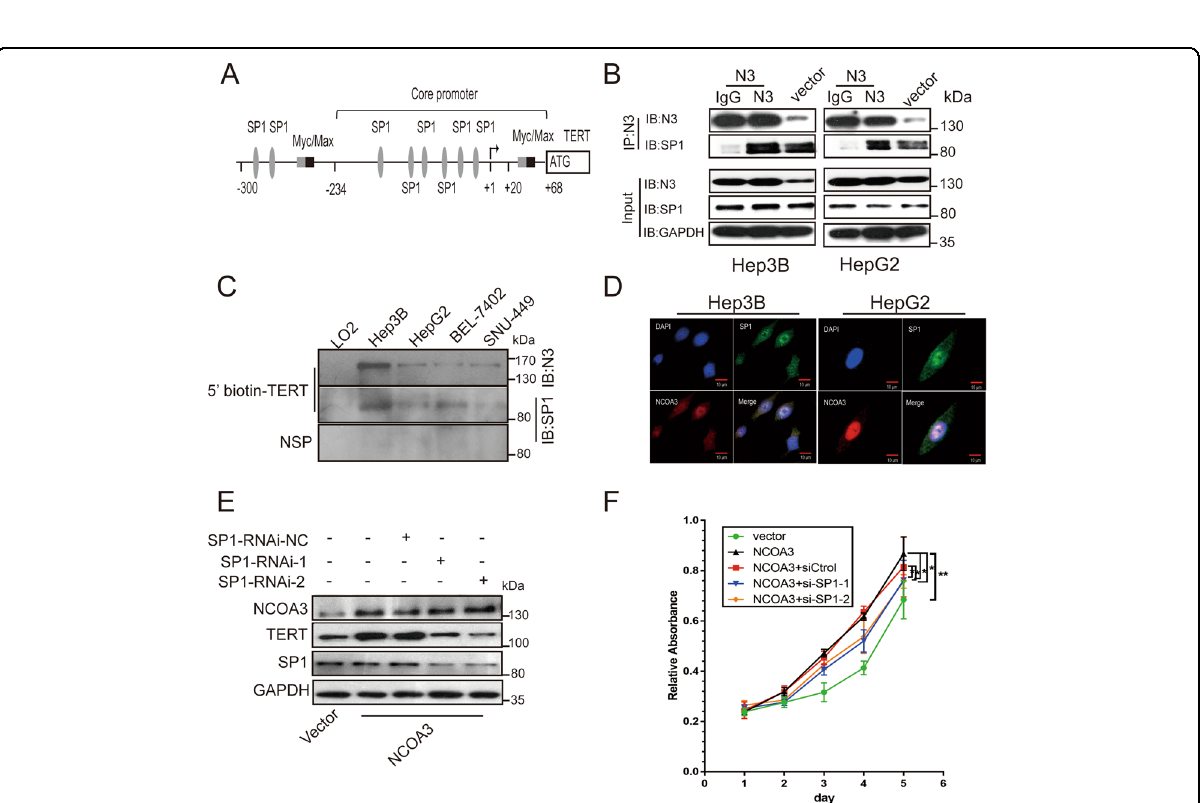
Fig. 5 NCOA3 interacted with SP1 to promote TERT expression and HCC cell growth. A Illustration of the SP1 binding sites in the TERT promoter. B The interaction between NCOA3 and SP1 was tested by co-IP in Hep3B and HepG2 cells without (vector) or with NCOA3 overexpression (N3). NCOA3 antibody was added to the nuclear extracts to precipitate proteins interacting with NCOA3, while IgG was used as a negative control. SP1 was then detected by its speci fi c antibody in the precipitates. C The 5 ′ biotin-labeled TERT promoter probe was pulled down by NCOA3 antibody in immortalized LO2 and HCC (Hep3B, HepG2, BEL-7402, and SNU-449) cells, while a nonspeci fi c probe (NSP) was used as a negative control. SP1 was detected by its speci fi c antibody in the precipitates. D Immuno fl uorescence of NCOA3 (red) and SP1 (green) in Hep3B and HepG2 cells. E TERT expression was detected in Hep3B cells without (Sp1-RNAi-NC) or with SP1 knockdown (Sp1-RNAi-1, Sp1-RNAi-2). F Viability of Hep3B cells with NCOA3 overexpression and SP1 knockdown. The data were shown as means ± SD, * P < 0.05, ** P < 0.01, Student ’ s t test from three independent